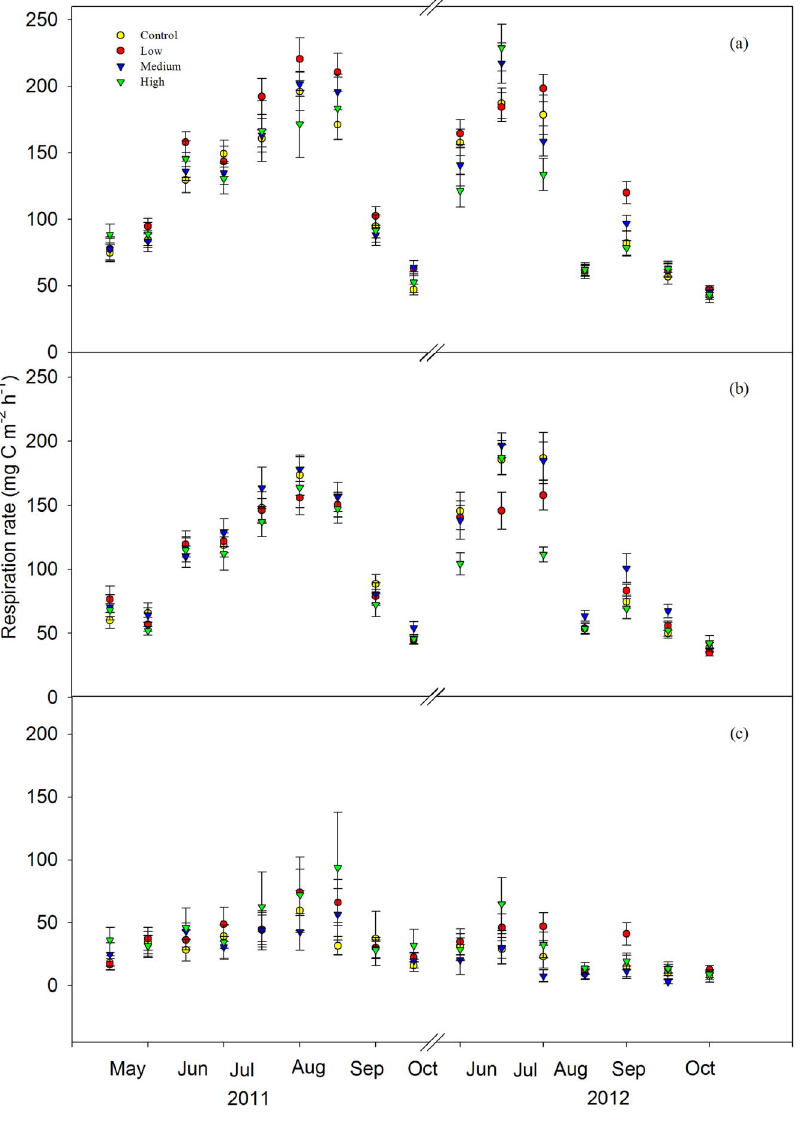
Figure 2. Soil respiration (a), heterotrophic respiration (b), and autotrophic respiration (c) in control (yellow circle), low-nitrogen (N) (red circle), medium-N (blue triangle), and high-N (green triangle) plots during the growing seasons of 2011 and 2012.